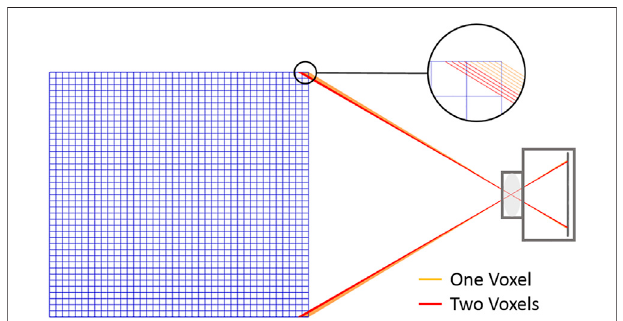
FIGURE 2 | The schematic diagram of light propagation in the fl ame voxel.